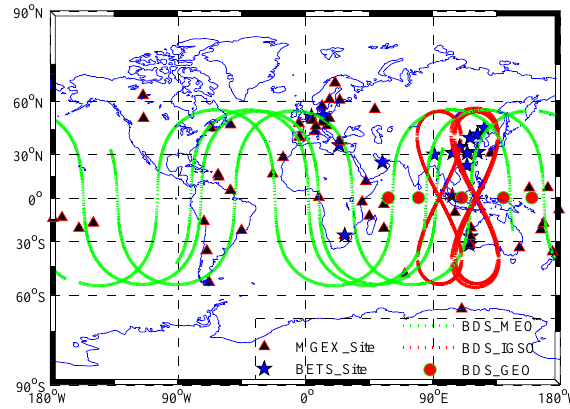
Figure 1. BDS satellite sub-trajectories for one day (15 February 2014) and the location of BDS continuously operating tracking sta- tions from the MGEX and BETS